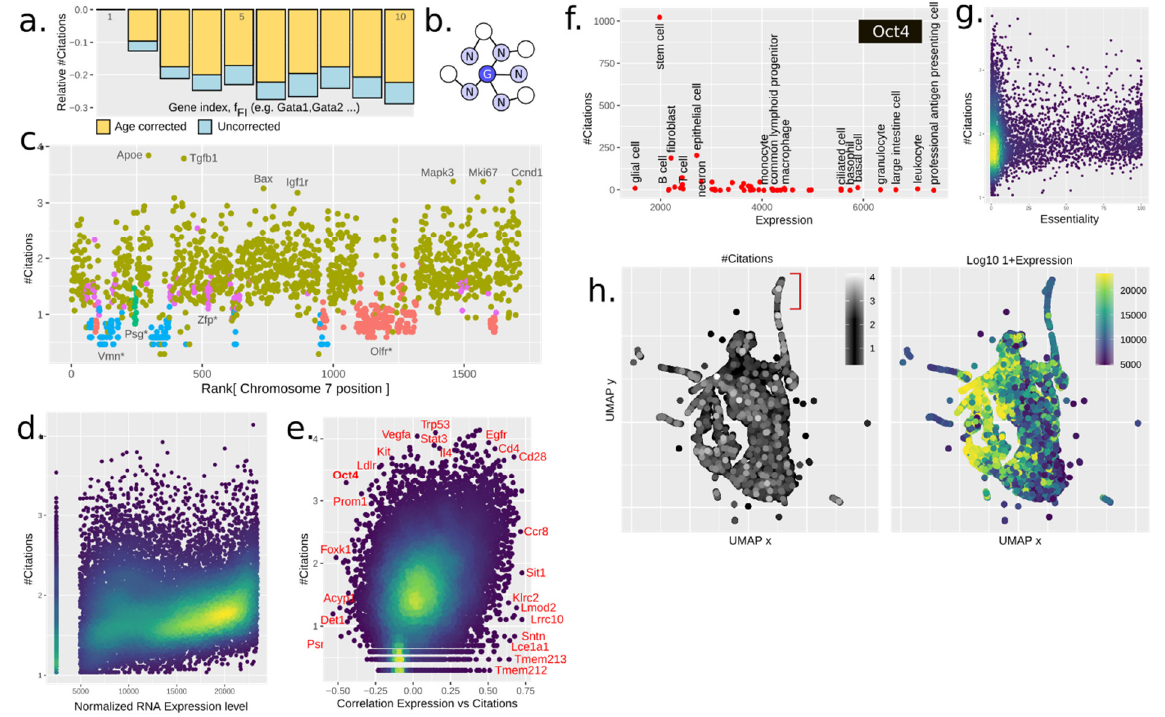
Figure 2. ( a ) Citation trends with relative #citations vs. gene family member’s index for the first 10 indices. Citations within gene families are normalized to index 1, which constitutes f founder . ( b ) Gene–gene graph representation. The average citations of neighboring genes in a gene–gene graph is used to define several features for each gene: f coexp , f PPI , and f chromatin . ( c ) f chromatin defined as #citations vs. ranked chromosome position of gene, for chromosome 7, colored by some gene families named at the bottom*. Chromosomal position is a highly dimensional feature that captures several relevant biological parameters and strongly influences the #citations. Gene families tend to show similar patterns of citation. ( d ) #Citations vs. RNA expression level (primary tissue normalized) for T lymphocytes. Highly expressed genes generally tend to positively correlate with #citations. ( e ) #Citations vs. Pearson correlation values of RNA expression—#citations across cell types. The positive correlation trend observed in Figure 2d is consistent across cell types, thus reinforcing the idea of gene expression levels being a critical feature in gene popularity. ( f ) #Citations vs. cell type-specific expression level for the gene Oct4 . Despite being highly expressed on professional antigen presenting cells, the cellular context in which Oct4 has been extensively cited is stem cell research. This hints at the existence of underlying features not included within this study that might be paramount drivers of gene popularity. ( g ) f essentiality defined as #Citations vs. cellular essentiality. Gene essentiality shows a positive correlation trend with gene popularity. This highlights that genes important for basic cell biology tend to produce a phenotype, which in turn facilitates gene reporting and enhances popularity. ( h ) UMAP projection of single-cell RNA-seq data showing the co-expression network (T cells, each point is a gene) colored by expression level and number of citations. A group of highly cited genes is pointed out in red.